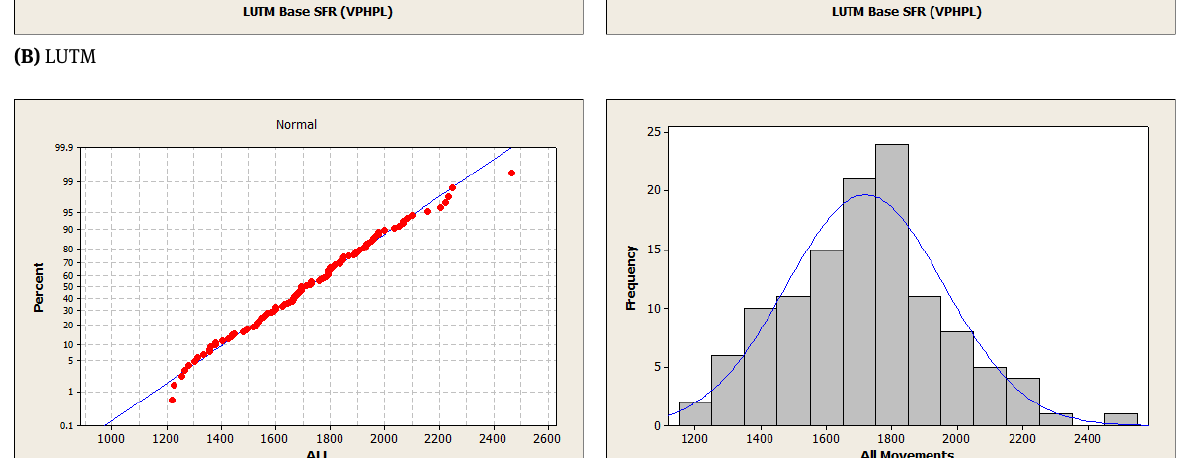
– Number of lanes : categorical variable (from 1 to 6